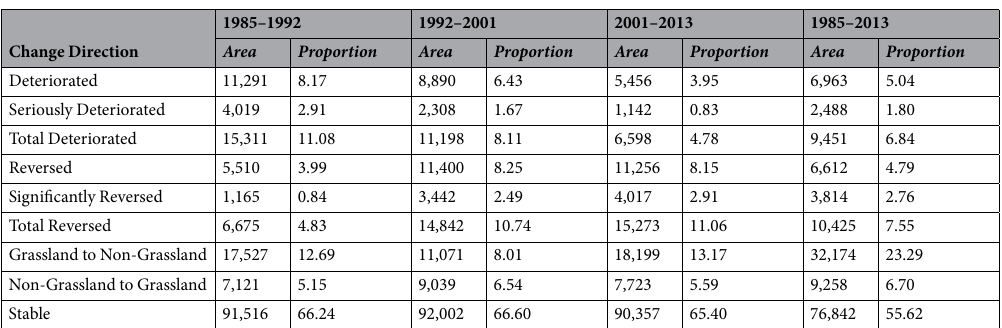
Table 2. Spatio-temporal dynamic changes over different periods (area: km 2 ; proportion: %).